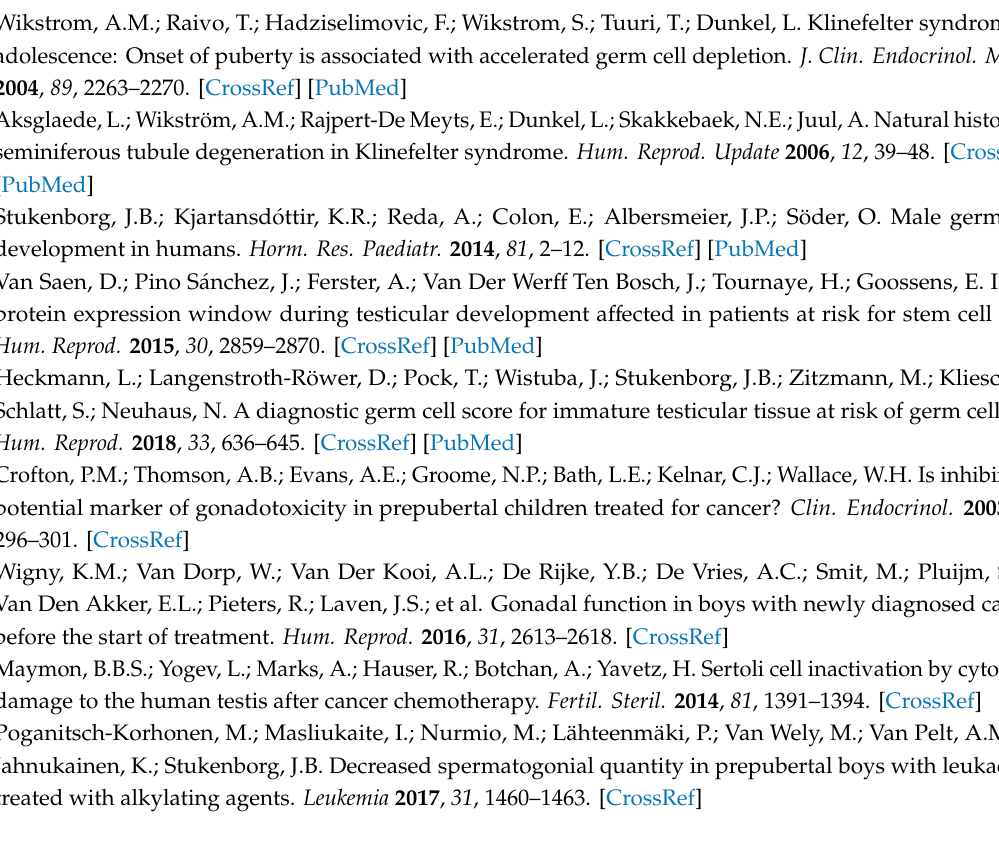
Figure S1: Spermatogonial marker-specific density in patients with potentially a ff ected testicular tissue (AT group) particularly due to cryptorchidism (CT), sickle cell disease (SCD), and thalassemia (THL) in comparison with established reference values (NT group) and patients within the AT group without the respective pathology. Table S1: Primary antibodies and immunohistochemistry protocol specifications. Table S2: Total number of evaluated cells and density of spermatogonia (Spg) evaluated for each patient (NT and AT groups) and adult controls